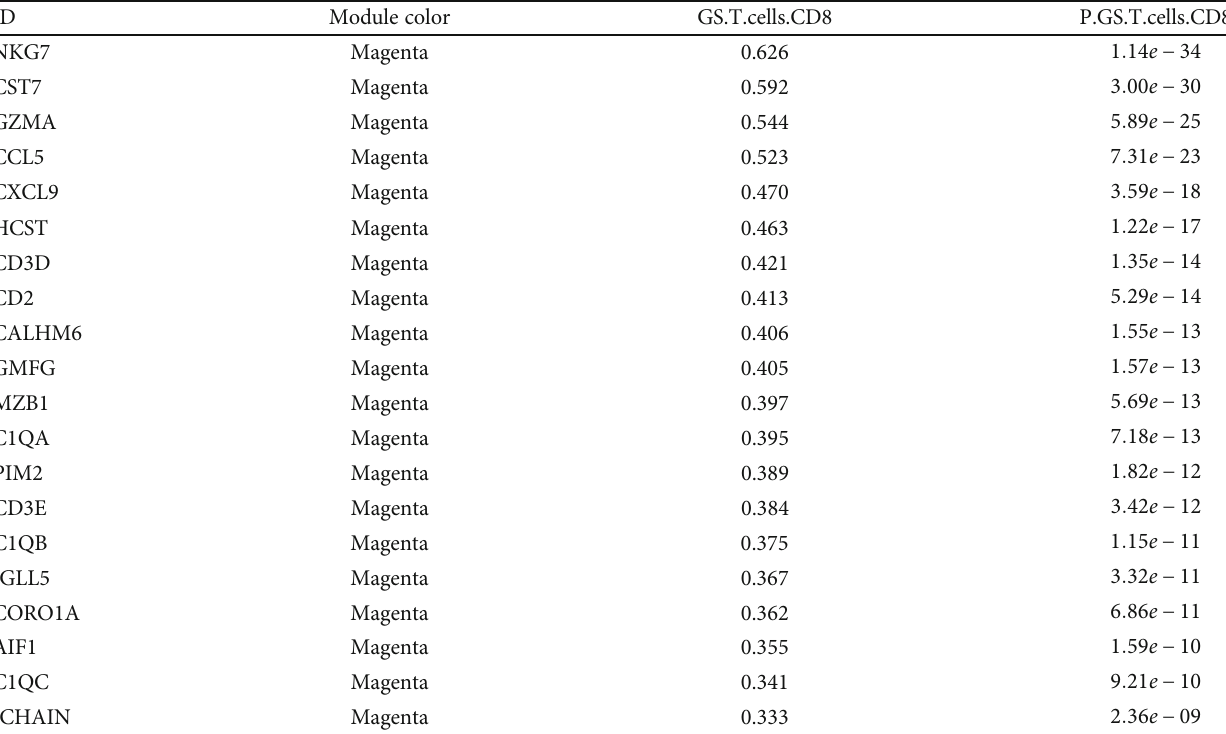
Table 2: The module and gene signi fi cance for CD8+ T cell-related genes in the magenta module.